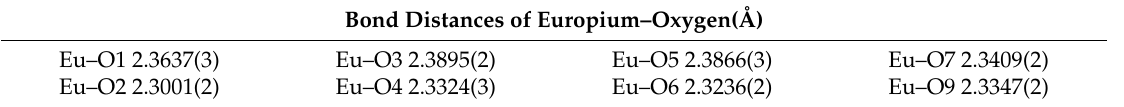
Table 2. Bond distances europium–oxygen (Å) for complex 3 .